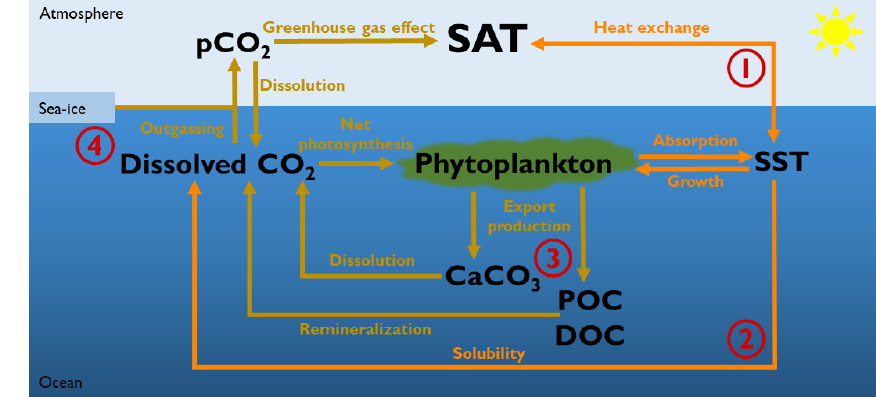
Figure 1. Representation of the four different biologically induced pathways that affect the atmospheric temperature. (1) Marine biota via phytoplankton light absorption increases the SST, changing therefore the air–sea heat exchange and the atmospheric temperature. (2) Changes in SST also alter the solubility of CO 2 and its dissolved concentration. In turn, changes in dissolved CO 2 concentrations alter the air–sea CO 2 exchange and thus the greenhouse gas effect. (3) Phytoplankton light absorption modifies the marine biogeochemical cycles and particularly the export production of carbon. These changes in export production of carbon modify the dissolved CO 2 concentration and the greenhouse gas effect. (4) A warmer surface of the ocean can decrease the sea-ice extent. A reduction of sea-ice cover increases the air–sea CO 2 exchange area, changing the greenhouse gas concentrations. SAT: surface atmospheric temperature. SST: sea surface temperature. CaCO 3 : calcium carbonate. POC: particulate organic carbon. DOC: dissolved organic carbon.